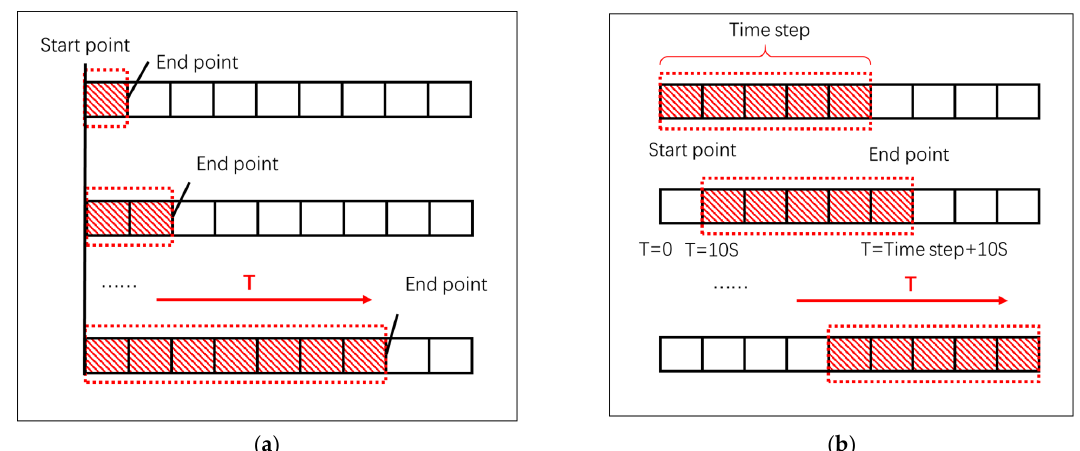
Figure 3. Schematic diagram of sliding time window sampling. ( a ) Fixed-point sliding window method; ( b ) dynamic sliding window